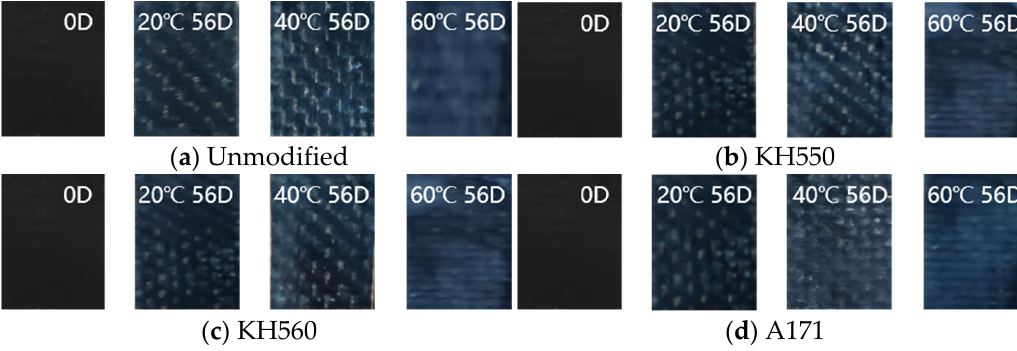
Figure 11. Appearance changes in a 10% NaOH alkali environment.